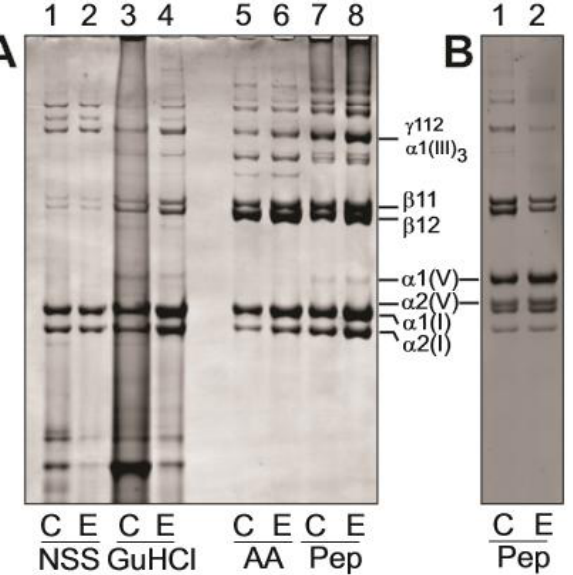
Figure 8. Dermal collagen extracellular matrix composition. Samples from control dermis (C) and EDS dermis (E) were extracted sequentially 0.15 M NaCl, 50 mM Tris-HCl buffer, pH 7.4 (neutral salt soluble, NSS), 4 M GuHCl, 0.5 M acetic acid (AA) and digestion with pepsin (Pep) at 100 μg/mL to